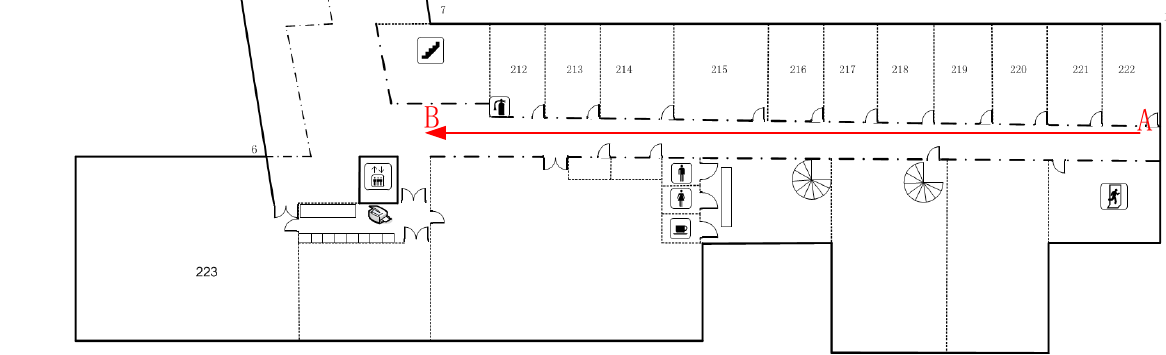
Figure 8. An overview map of the field test corridor and the straight trajectory.